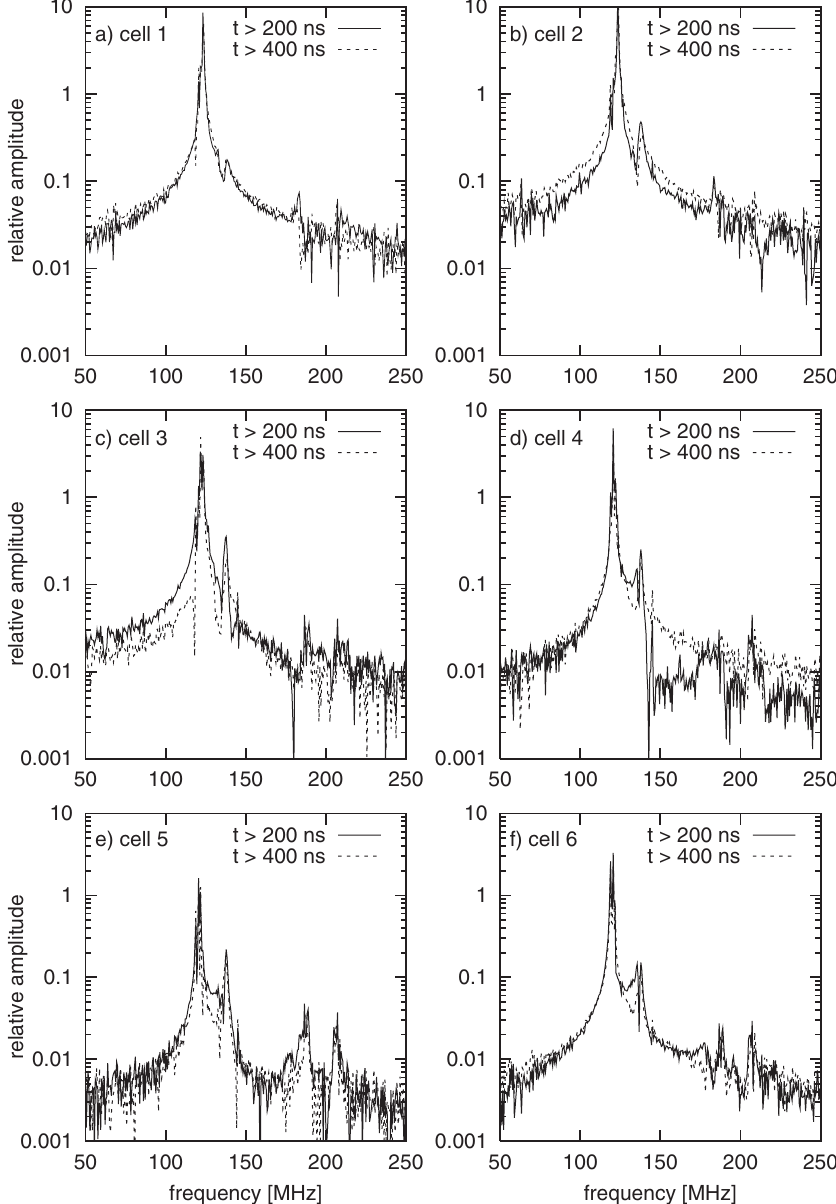
FIG. 7. Electric field spectra generated using a dipole current source located in cavity 2 with a frequency ramp from 116 to 141 MHz over 100 ns. Spectra are calculated for each RITS-6 cell for two time windows, 200 ns – 2 (cid:1) s and 400 ns – 2 (cid:1) s , to view the decay of the